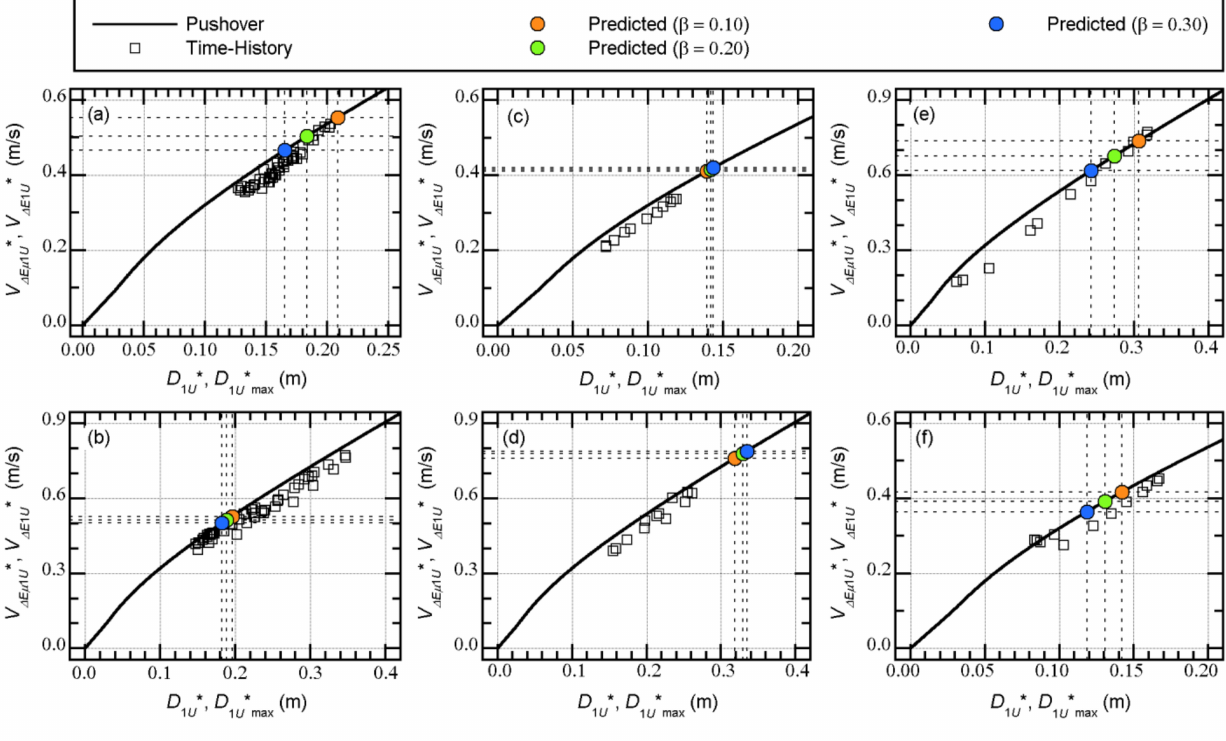
Figure 33. Comparison between the V ∆ E µ 1 U * – D 1 U * curve and the V ∆ E 1 U * – D 1 U * max relationship obtained from the time- history analysis (Model-Tf34): ( a ) Art-1 series; ( b ) Art-2 series; ( c ) UTO0414; ( d ) UTO0416; ( e ) TCU; ( f )